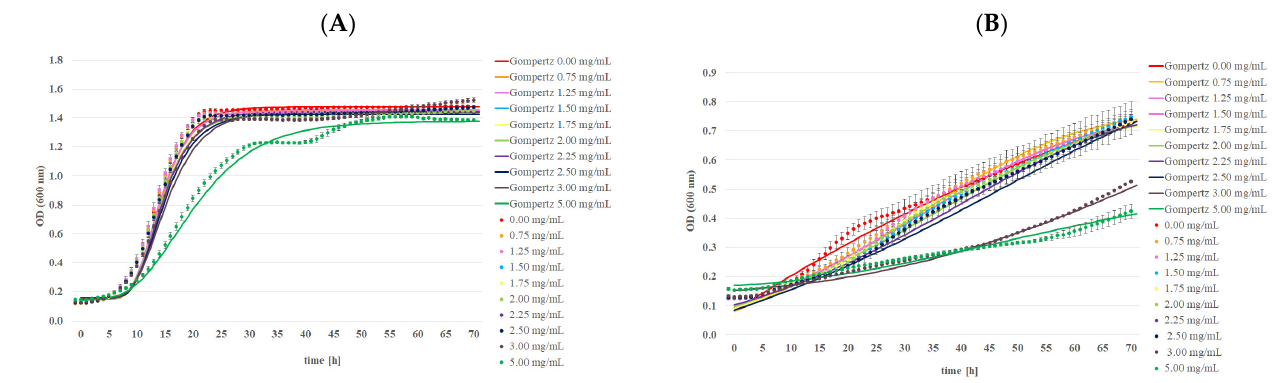
Figure 6. The effect of mandelic acid at different concentrations on the growth profiles of tested yeast strains: ( A ) C. albicans ATCC 10231 and ( B ) R. mucilaginosa KKP 3560, using Bioscreen C Pro. Table 7. The MIC and MBC of mandelic acid against tested microorganisms.